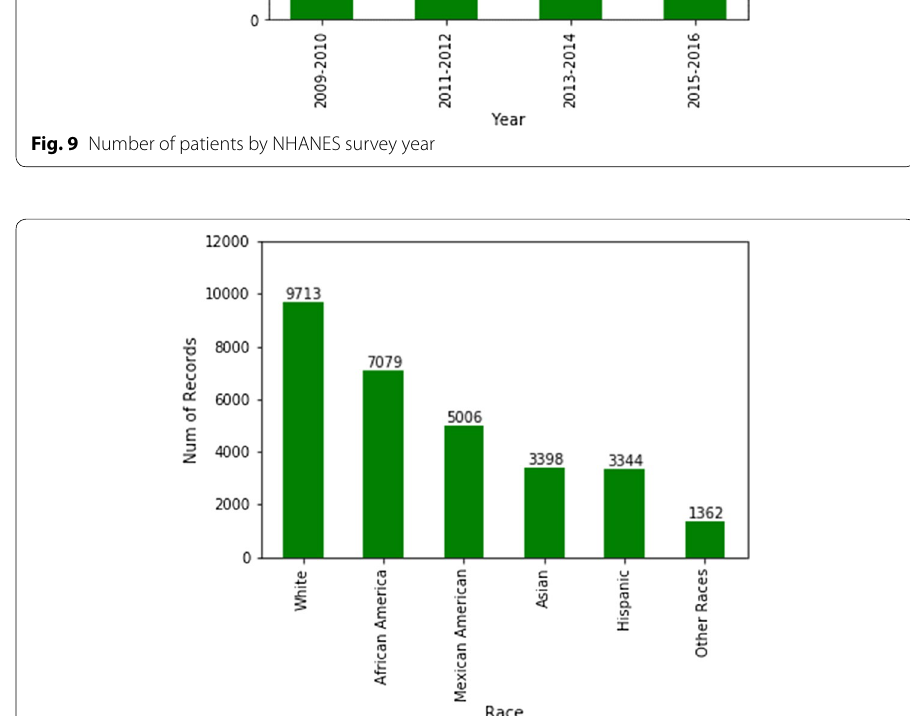
Fig. 10 Counts of patients per race in NHANES